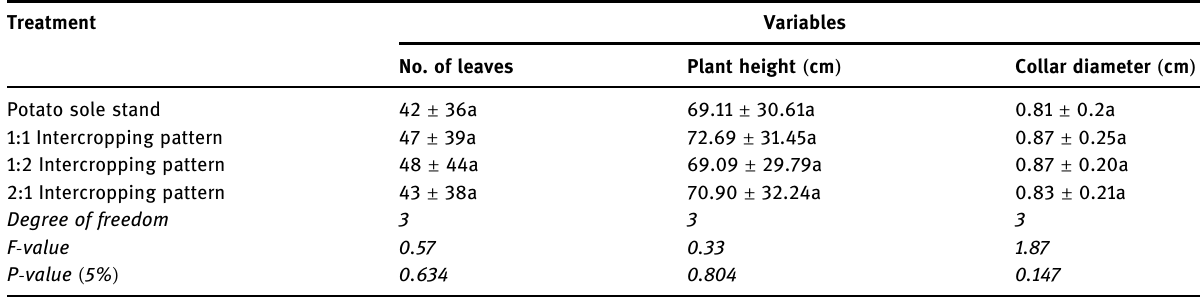
Table 1: E ff ects of intercropping pattern on potato growth variables